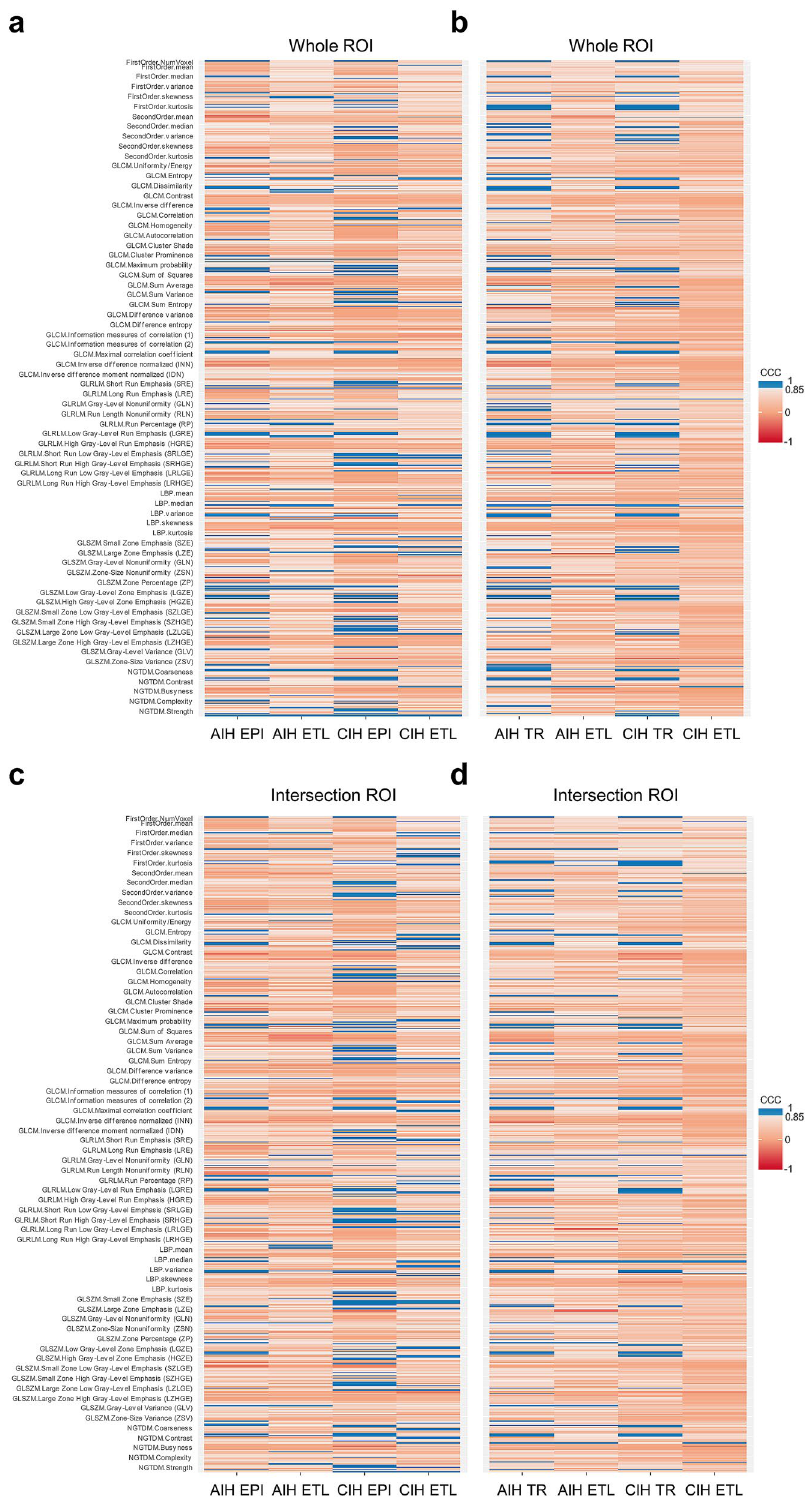
Figure 1. Heat maps of radiomics features extracted from whole- and intersection ROI masks in the first and second groups. Features with CCC > 0.85 were regarded as stable. (a) Features from whole ROI masks in the first group. (b) Features from whole ROI masks in the second group. (c) Features from intersection ROI masks in the first group. (d) Features from intersection ROI masks in the second group. AIH acute ischemic hyperintensity, CIH chronic ischemic hyperintensity, CCC concordance correlation coefficients, ROI region-of-interest, EPI echo-planar imaging, ETL echo train length, TR repetition